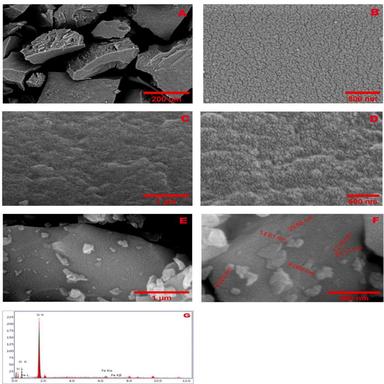
FE-SEM images of the, A) as-freeze-dried sample (Si0), B) magnified piece of the fragment of Si0, C) Si5, D) Si7, E) Si10, F) high magnification of Si10 and G) EDS analysis of the Si10 sample.